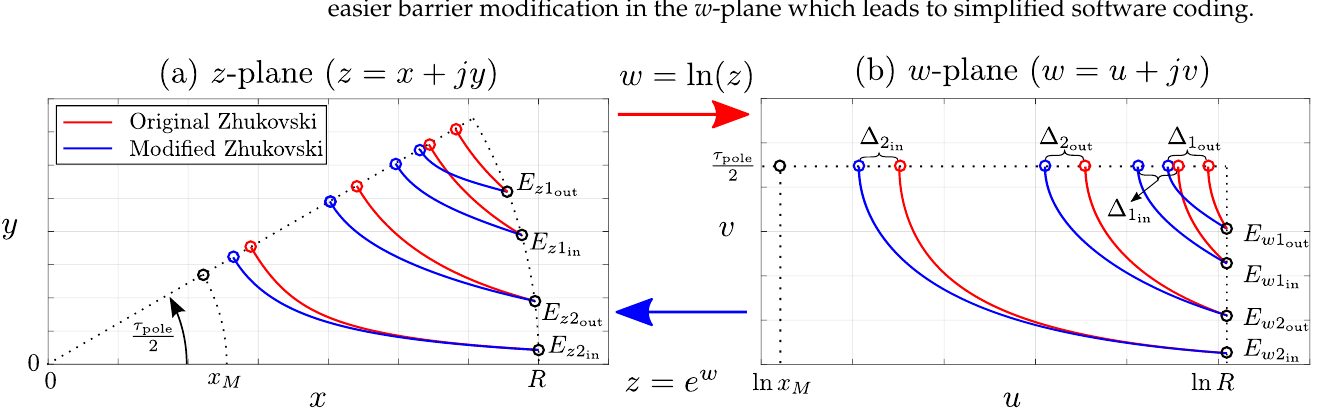
Figure 7. Modification of Zhukovsky lines via conformal